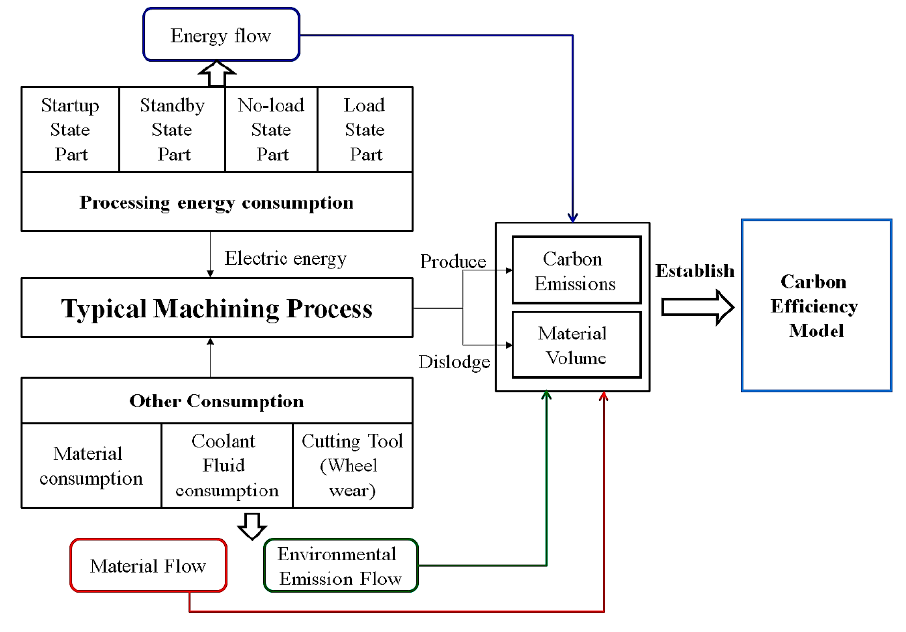
Figure 3. Carbon efficiency model.